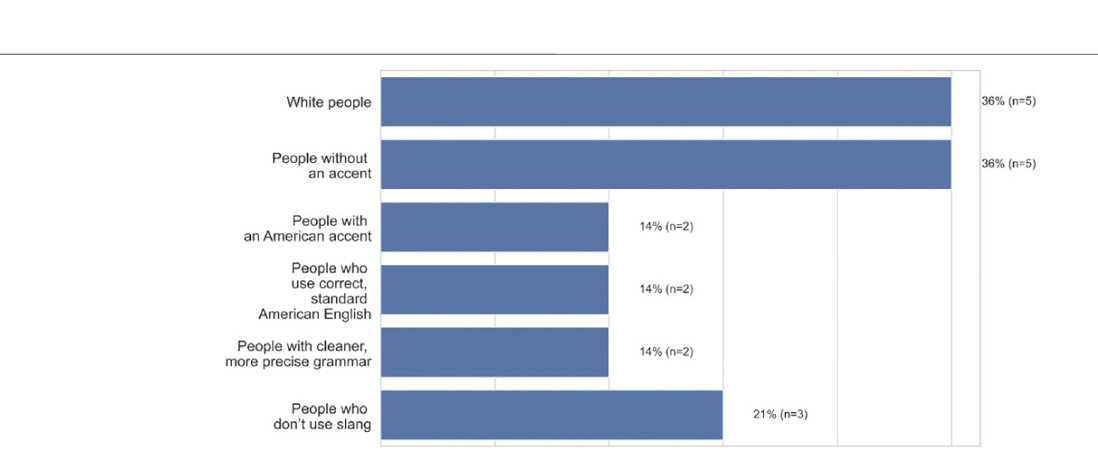
FIGURE 5 | Who African-American participants believe ASR technology works better for ( n (cid:1) 14).